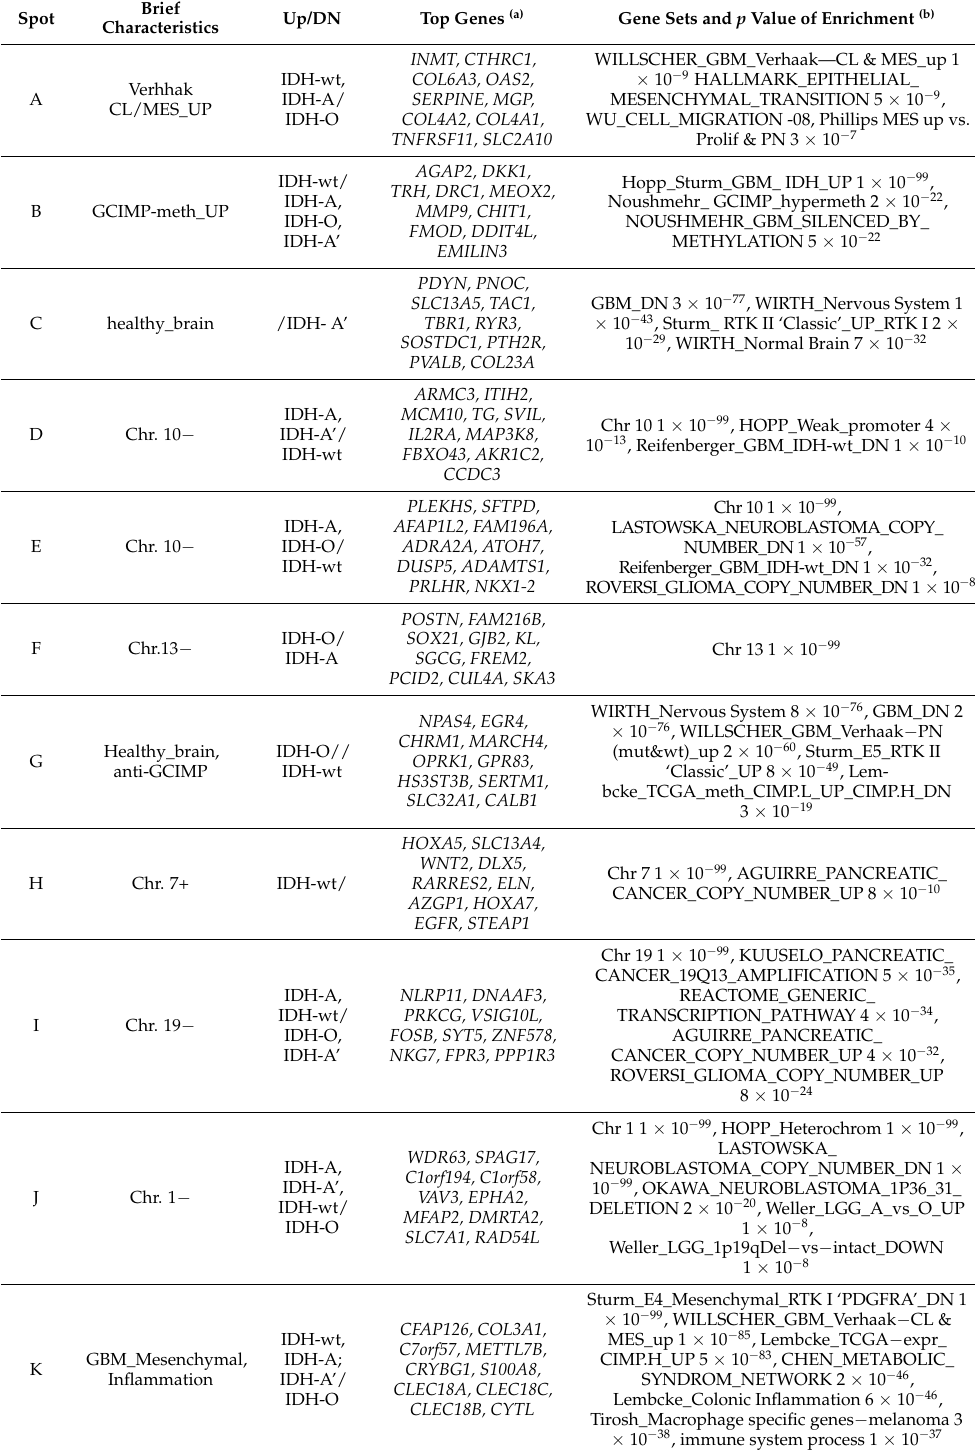
Table A1. Functional context of expression